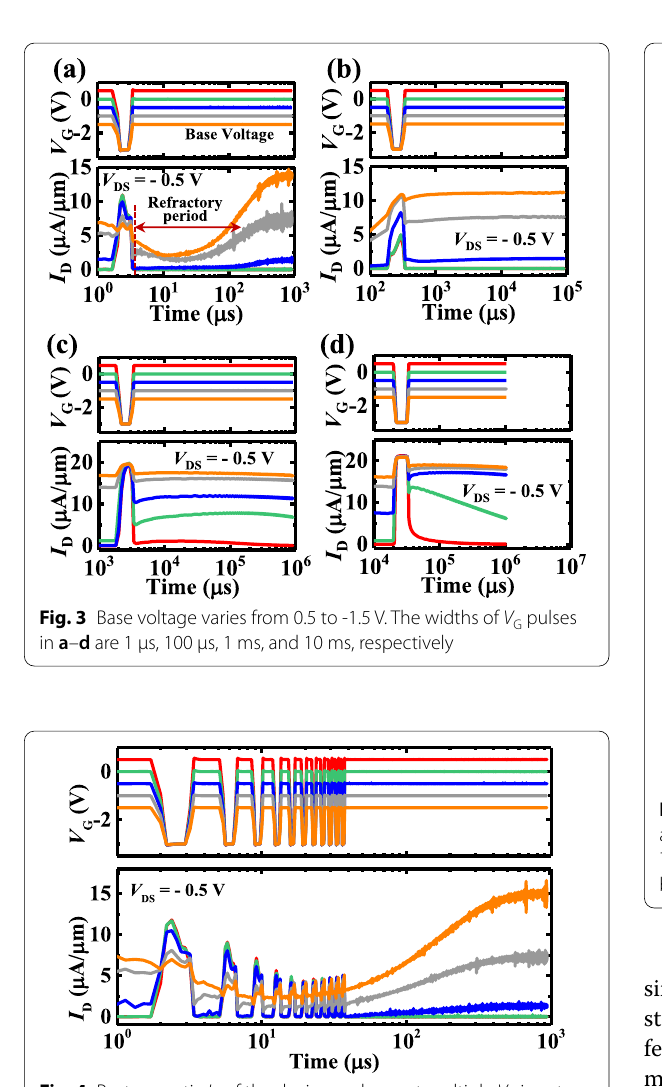
Fig. 4 Post-synaptic I D of the device underwent multiple V G input pulses within the relative refractory period